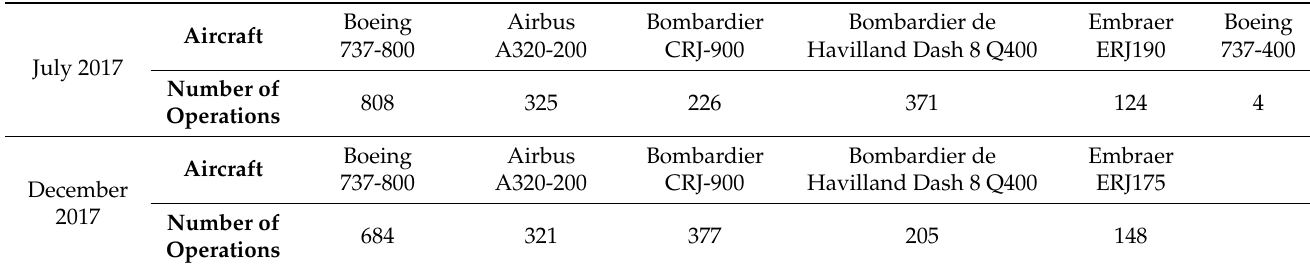
Table 1. Summary of aircrafts with which scheduled operations took place at the Nicolaus Copernicus Airport in July and December 2017, together with the number of operations.